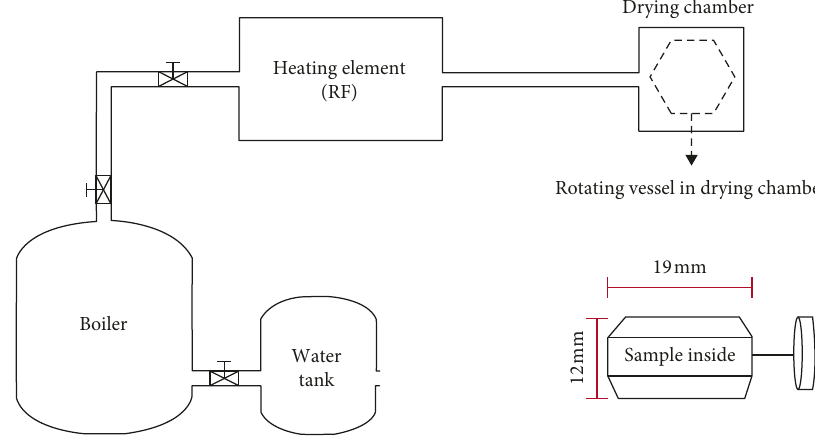
Figure 1: Schematic diagram of superheated steam